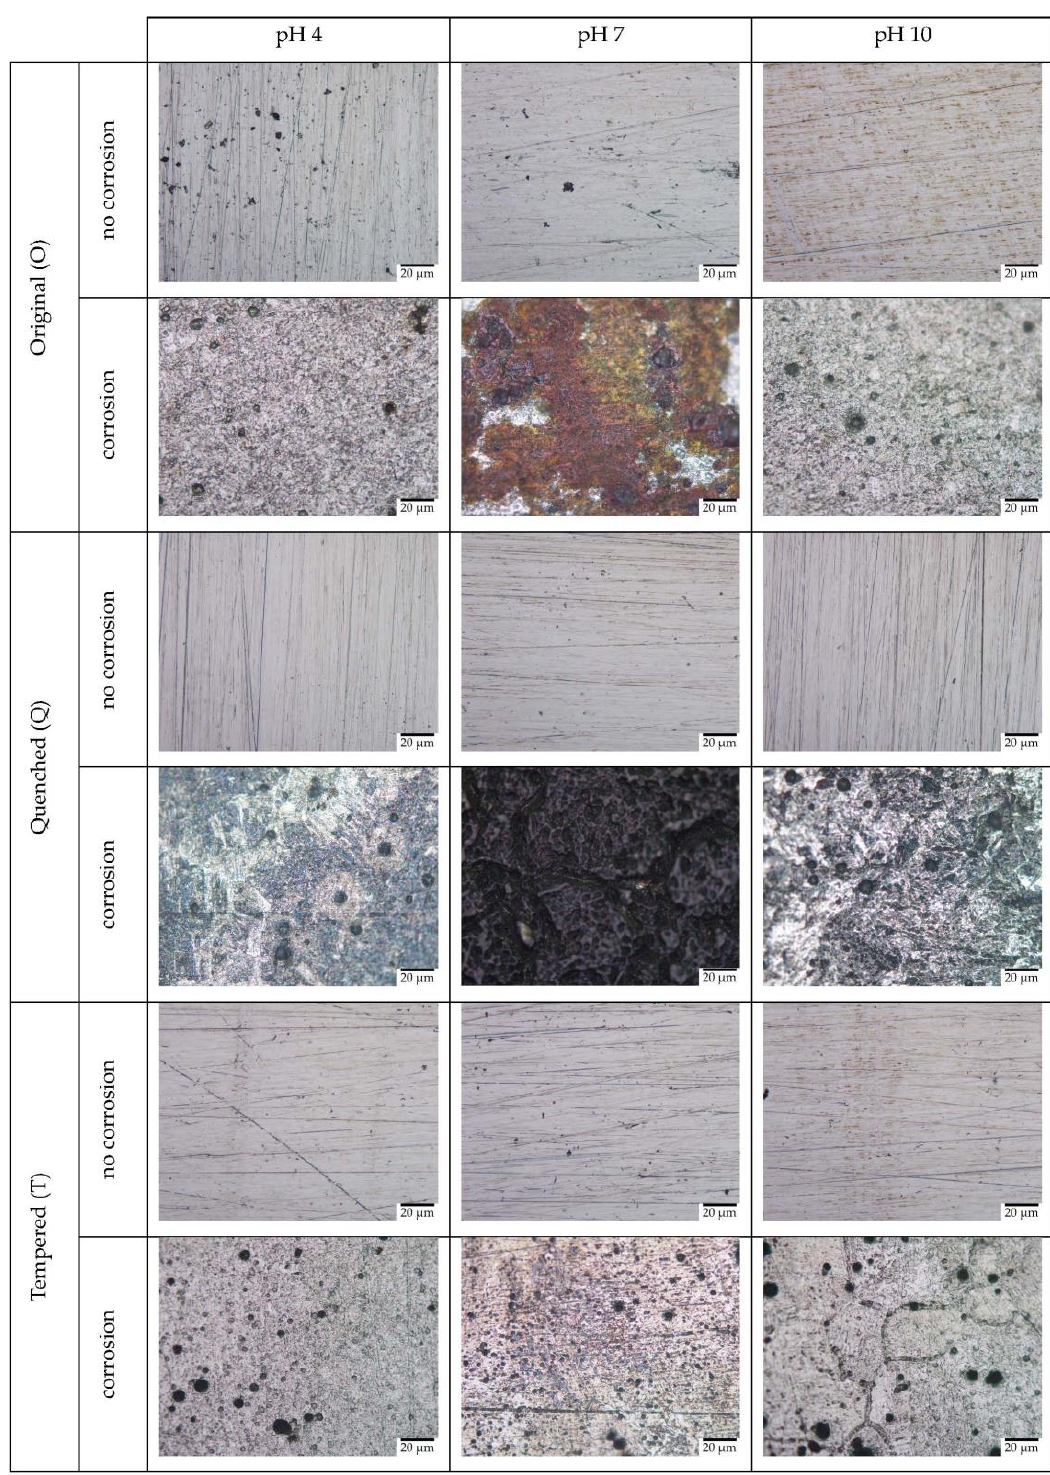
Figure 9. OM images of O, Q, and T samples before and after corrosion in chlorine-rich environment at pH 4, 7, and 10.